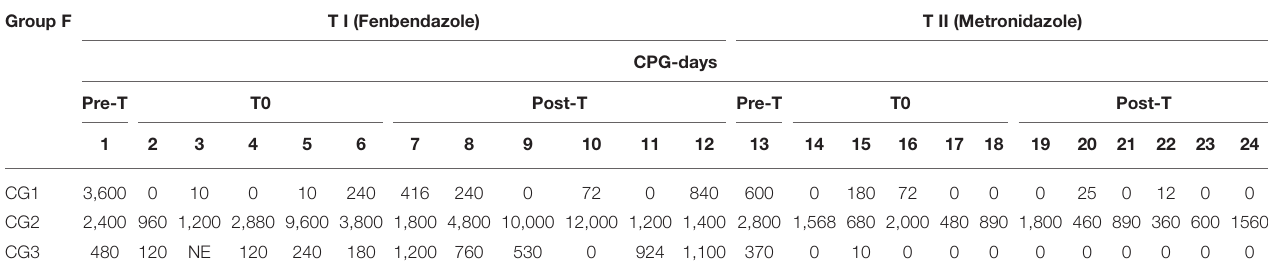
TABLE 2 | Results of Giardia cyst per gram (CPG) for all the animals in each cage (CG1, CG2, and CG3) during the entire study (pre-treatment and post-treatments T1 and T2) for Group F. Group F